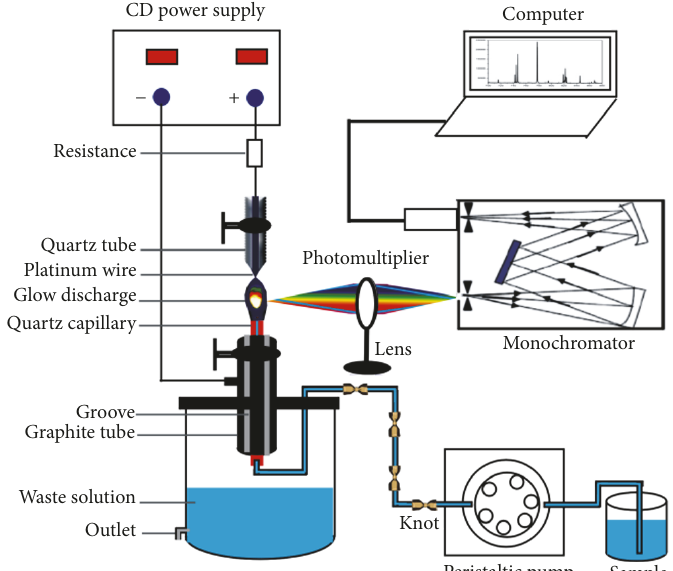
Figure 1: Schematic diagram of the experiment setup.